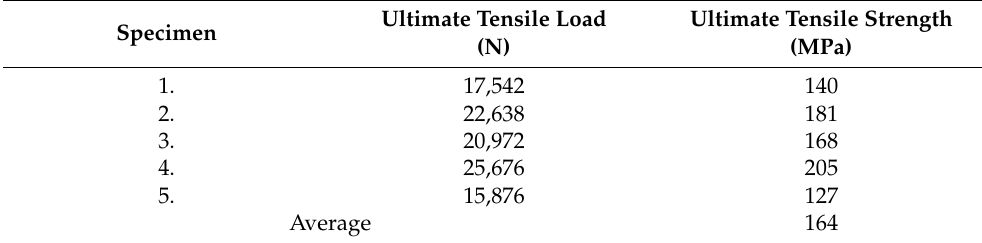
Table 2. Result of bamboo tensile test.